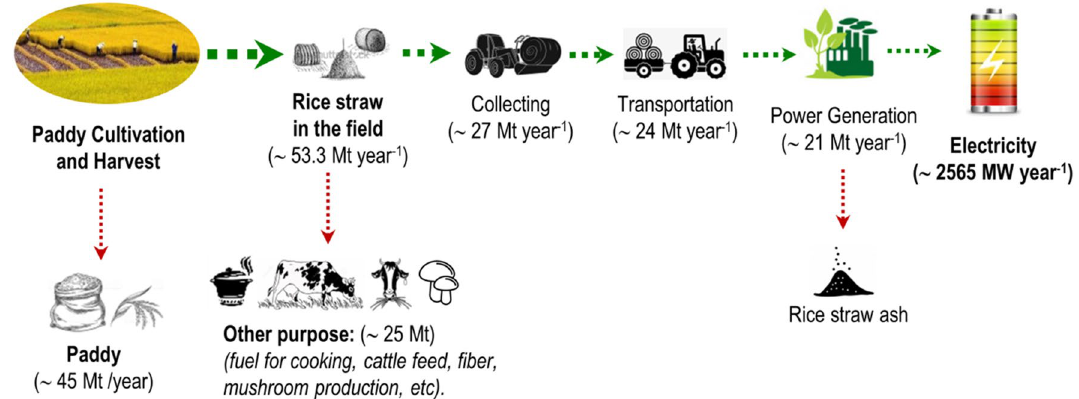
Figure 4. Mechanism and quantification of the potential use of rice straw for electricity generation in Vietnam. This map was generated using ArcGIS version 10.2 (https ://deskt op.arcgi s.com/en/arcma